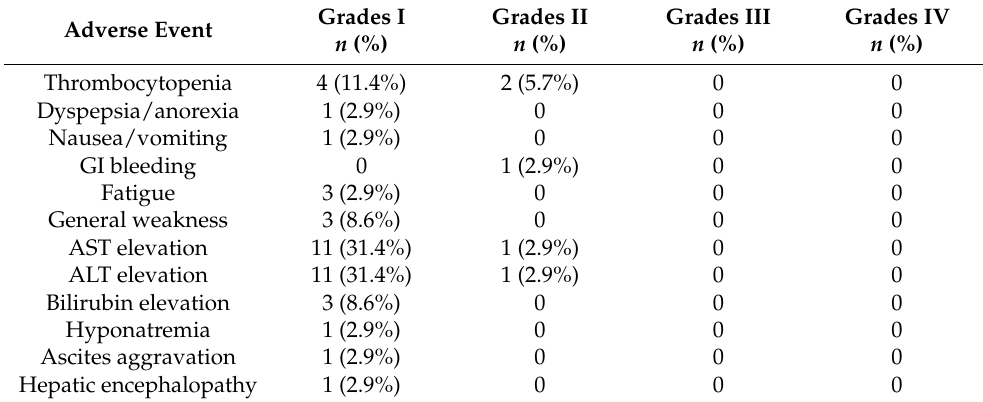
Figure 3. Kaplan–Meier curves for OS ( a ) and TTP ( b ) in patients, stratified by treatment with or without anti-PD-1 immunotherapy. Table 3. HAICROX associated with adverse events in 35 HCC